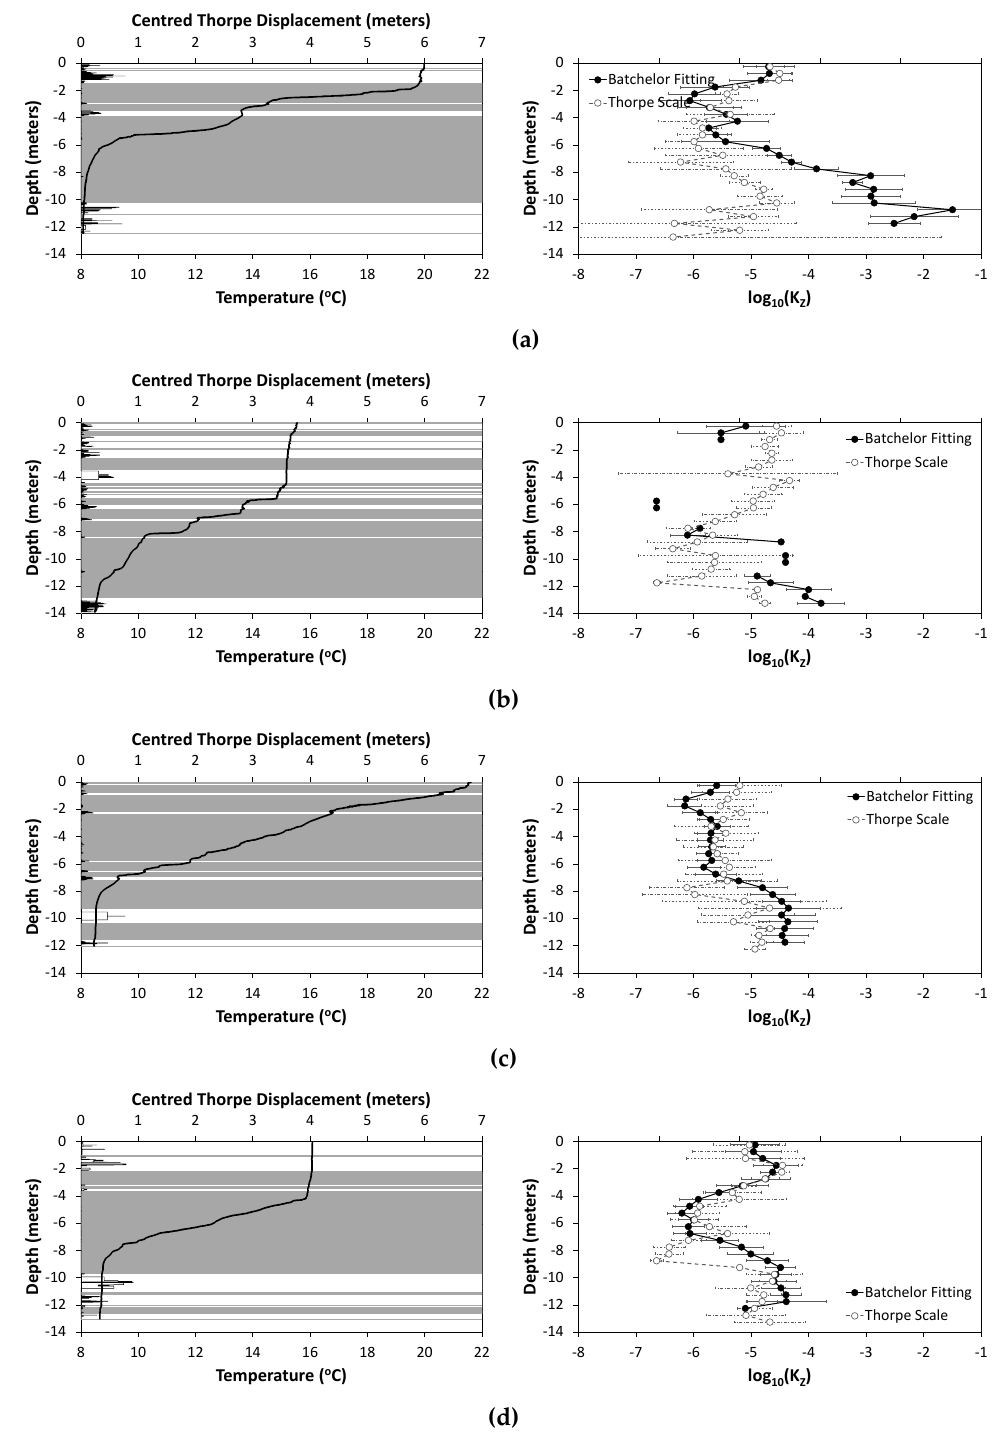
Figure 6. As for Figure 5, for Blelham Tarn. Profiles recorded at ( a ) 13:33 on 9 June; ( b ) 12:41 on 23 June; ( c ) 11:07 on 28 July; ( d ) 11:00 on 11 August.